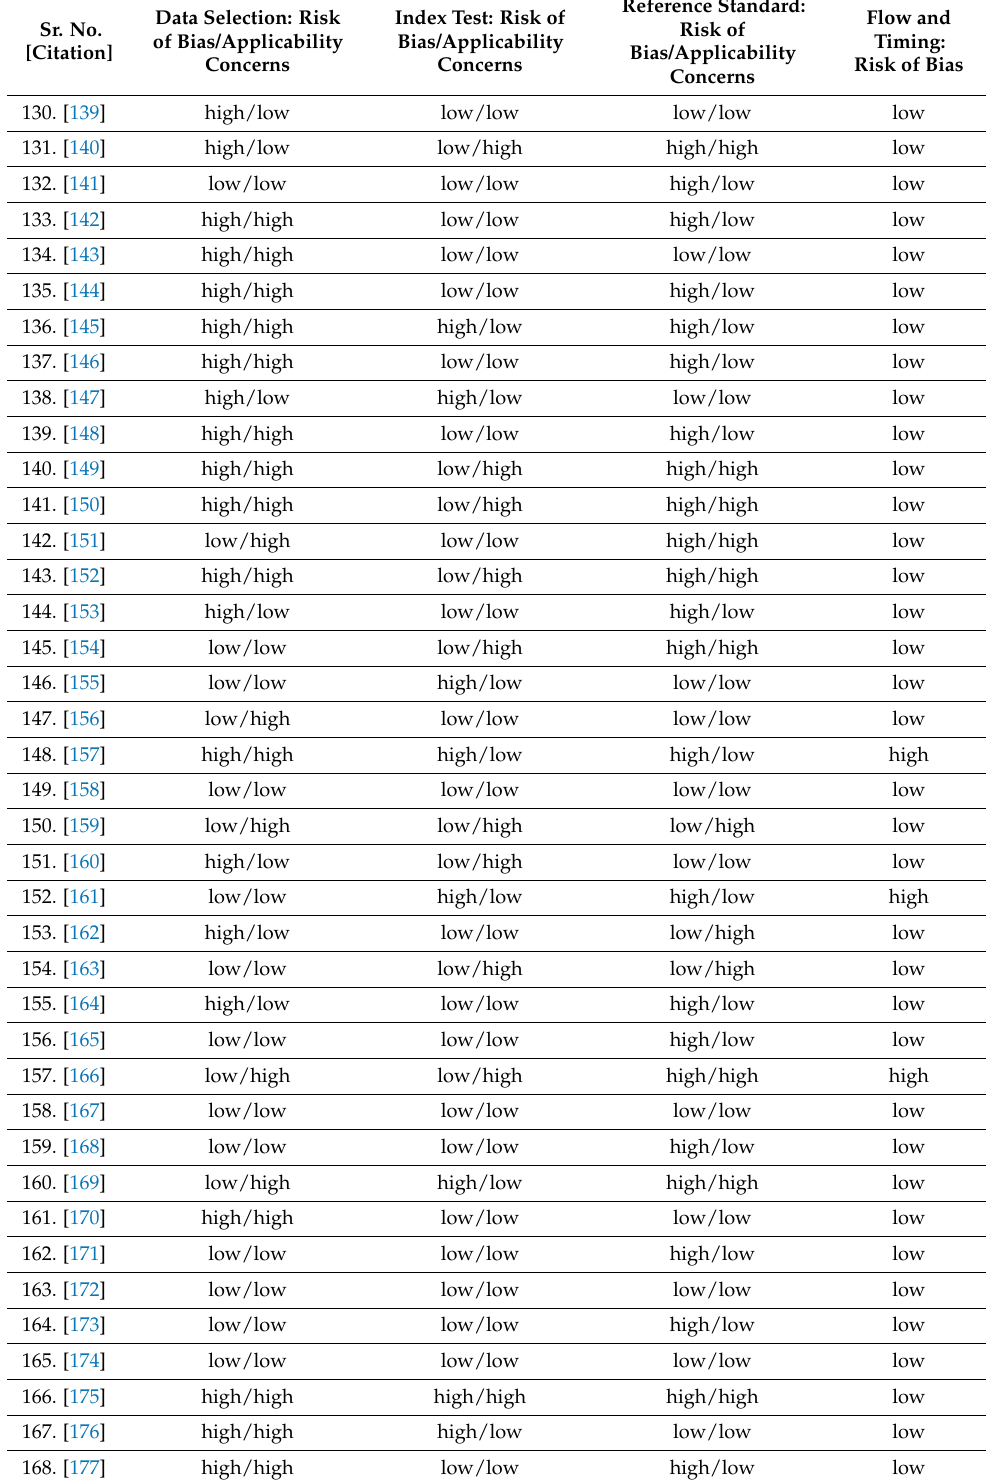
Table 1. Cont. Data Selection: Risk Sr. No. of Bias/Applicability [Citation] Concerns